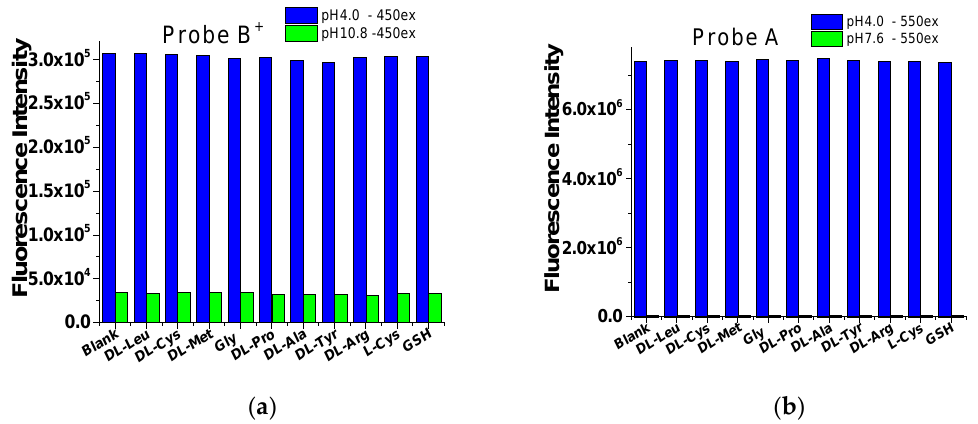
Figure 8. Fluorescence intensity of probes A and B + in the absence and presence of 50 µM different amino acid and biothiols at pH 4.0 and 11.3 under excitation of 450 nm for probe B + ( a ) and under 550 nm excitation for probe A ( b ).